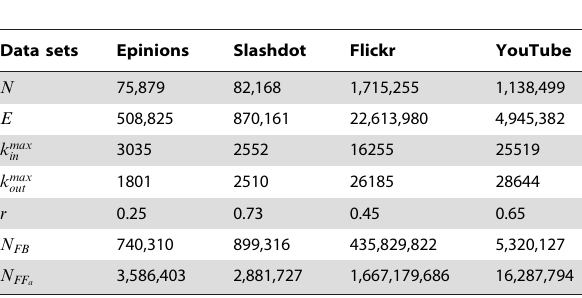
Table 1. Basic statistics of the four online social network datasets.